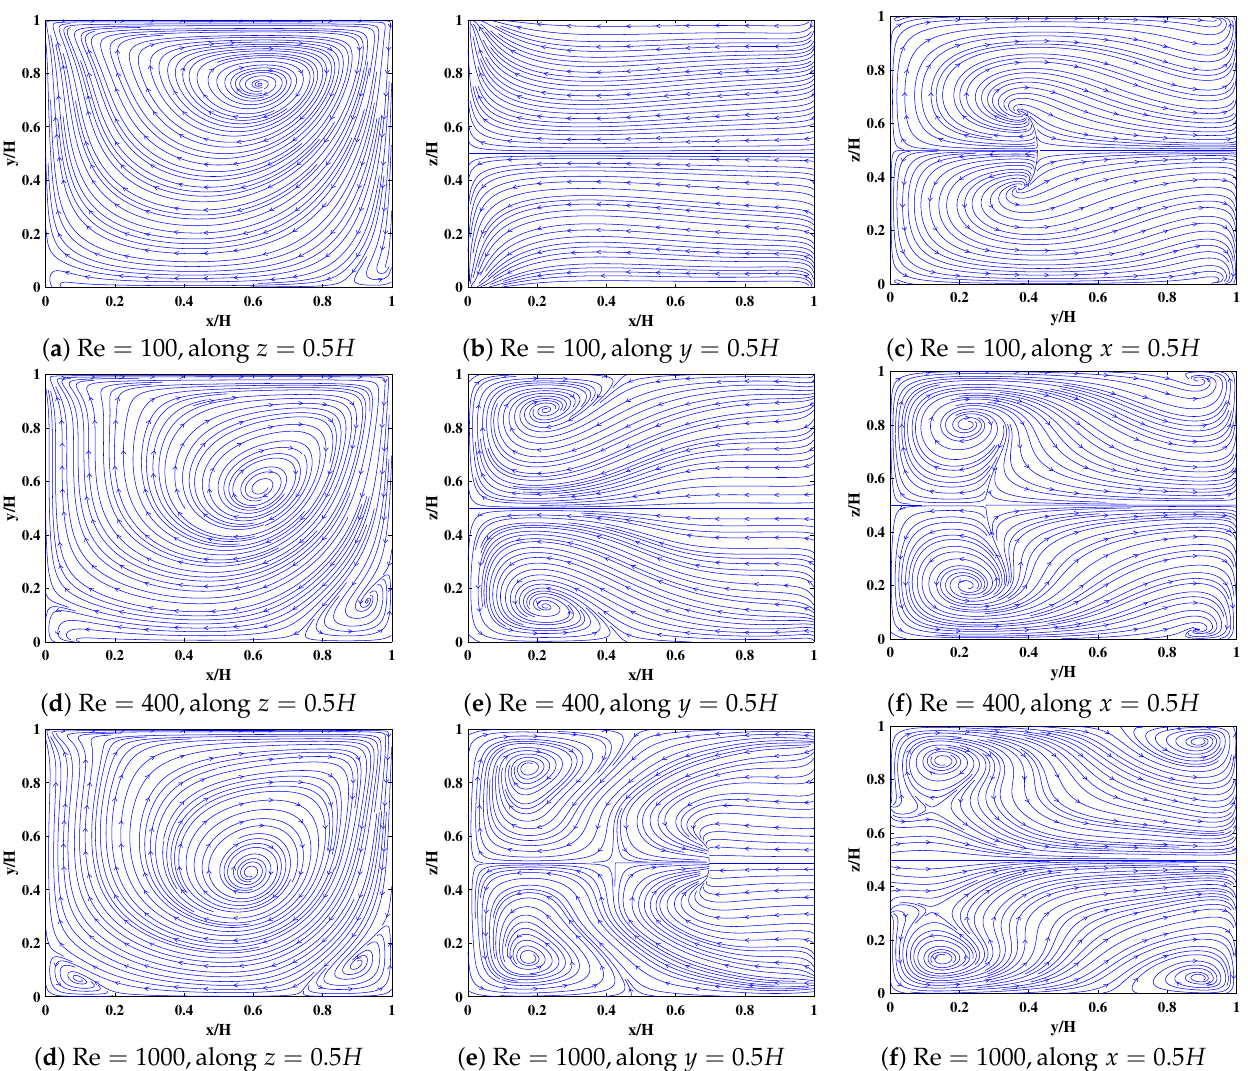
Figure 8. Projections of the streamlines in the 3D lid-driven cubic cavity flow along three different mid-planes computed using 3DCCM-LBM with a grid aspect ratio of r = 0.5 and s = 1.0 at Re = 100 ( a – c ), Re = 400 ( d – f ) and Re = 1000 ( g – i ) at z = 0.5 H , y = 0.5 H , and x = 0.5 H ,